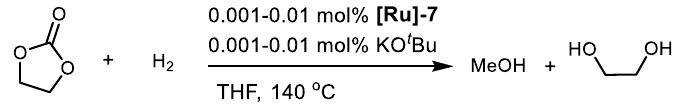
Figure 12. Ruthenium catalyzed hydrogenation of cyclic carbonates.